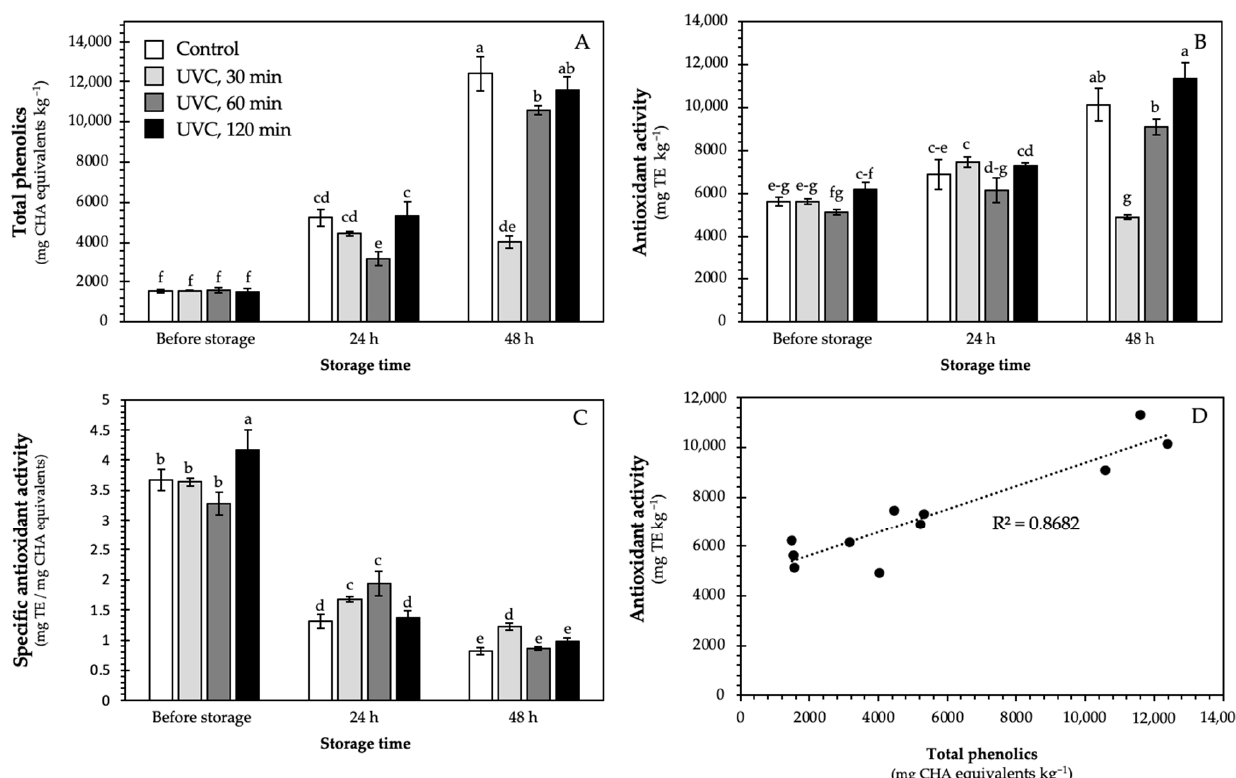
Figure 1. Total phenolic content ( A ), antioxidant activity ( B ), specific antioxidant activity ( C ), and correlation of antioxidant activity against phenolic content ( D ) of carrot pomace treated with UVC for 0 (control), 30, 60, or 120 min, and stored at 25 °C for 48 h. Data represent the mean of 3 repetitions ± the standard error of the mean. Different letters among bars (a, b, c, d, e, f, and g) indicate a statistical difference between treatments using the LSD test ( p < 0.05). Abbreviations: CHA: chlorogenic acid; TE: Trolox equivalents.